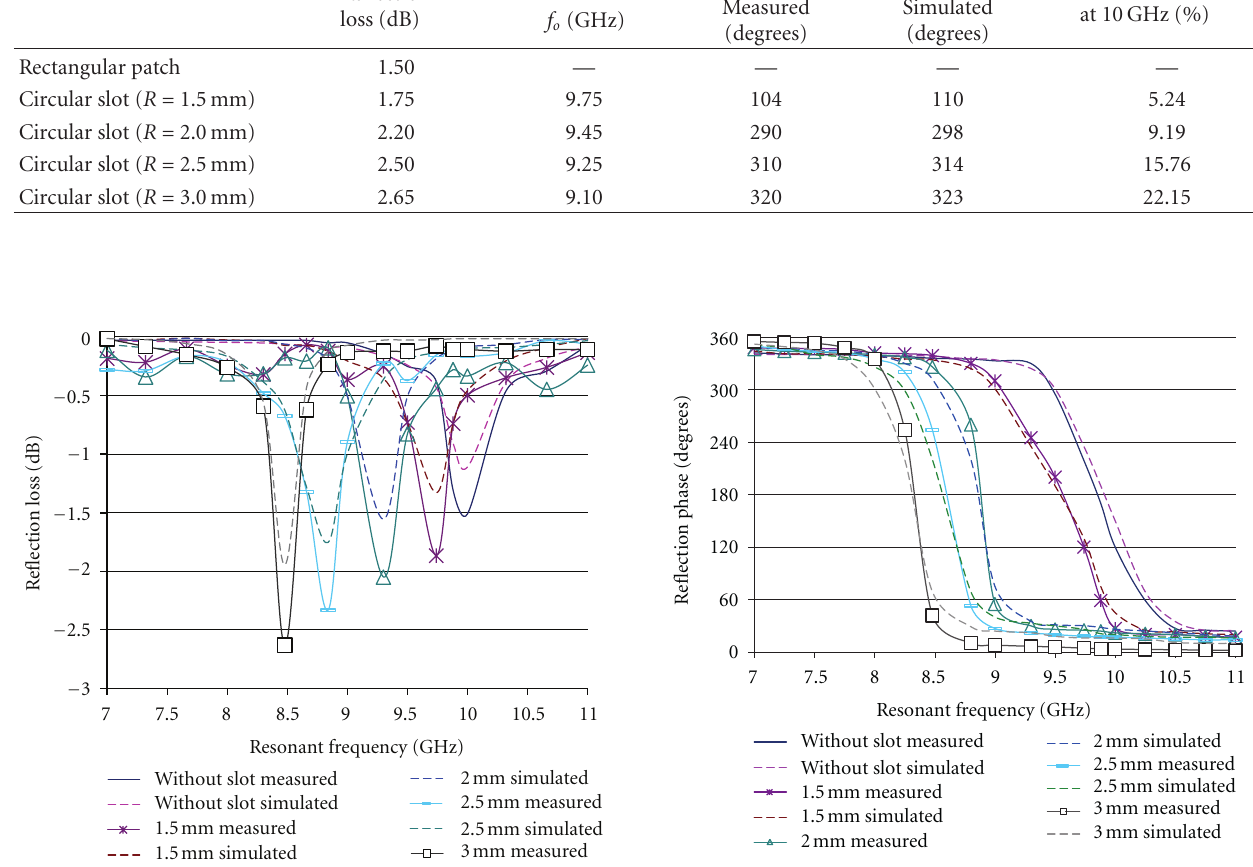
Figure 5: Measured and simulated reflection phase for patch without slot and patch with di ff erent radius of circular slots in the centre of